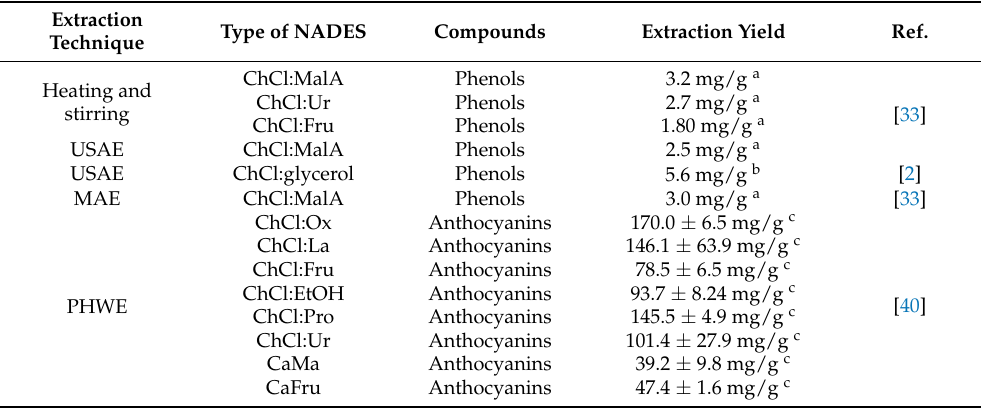
Table 1. Comparison of different extraction techniques with different mixtures of